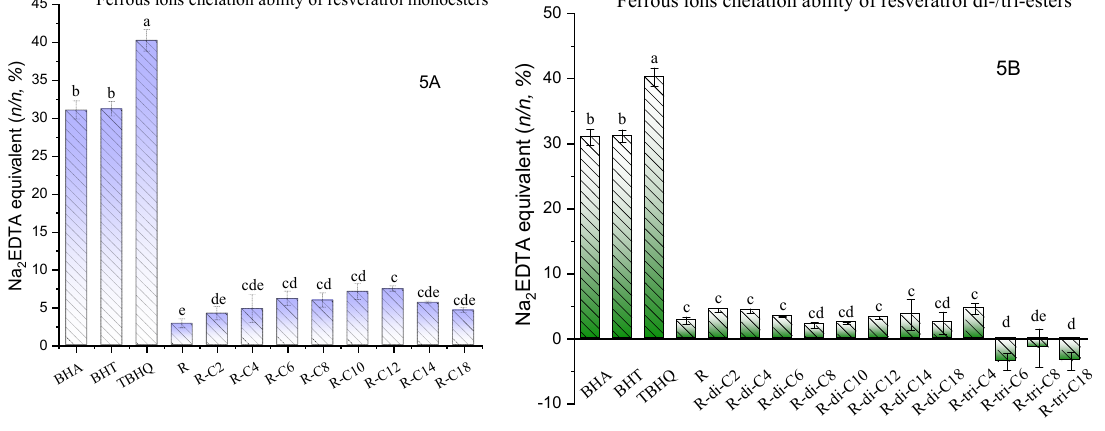
Figure 5. Ferrous ion-chelation ability of resveratrol esters. ( A ): Ferrous ions chelation ability in mole efficacy equivalent of EDTA per mole of resveratrol (R) or its monoesters (%, n/n ). R-C2, R-C4, R-C6, R-C8, R-C10, R-C12, R-C14, R-C18 are resveratrol esters of acetic, butyric, caproic, caprylic, capric, lauric, myristic, and stearic acids, respectively. ( B ): Ferrous ions chelation ability in mole efficacy equivalent of EDTA per mole of resveratrol (R) or its di-/triesters (%, n/n ). R-di-C2, R-di-C4, R-di-C6, R-di-C8, R-di-C10, R-di-C12, R-di-C14, and R-di-C18 are resveratrol diesters of acetic, butyric, caproic, caprylic, capric, lauric, myristic, and stearic acids, respectively; R-tri-C4, R-tri-C6, R-tri-C8, and R-tri-C18 are resveratrol triesters of caproic, caprylic, capric, and stearic acids, respectively. Each experiment was replicated 3 times. Entries with different letters were significantly different at p < 0.05, performed by Tukey’s HSD